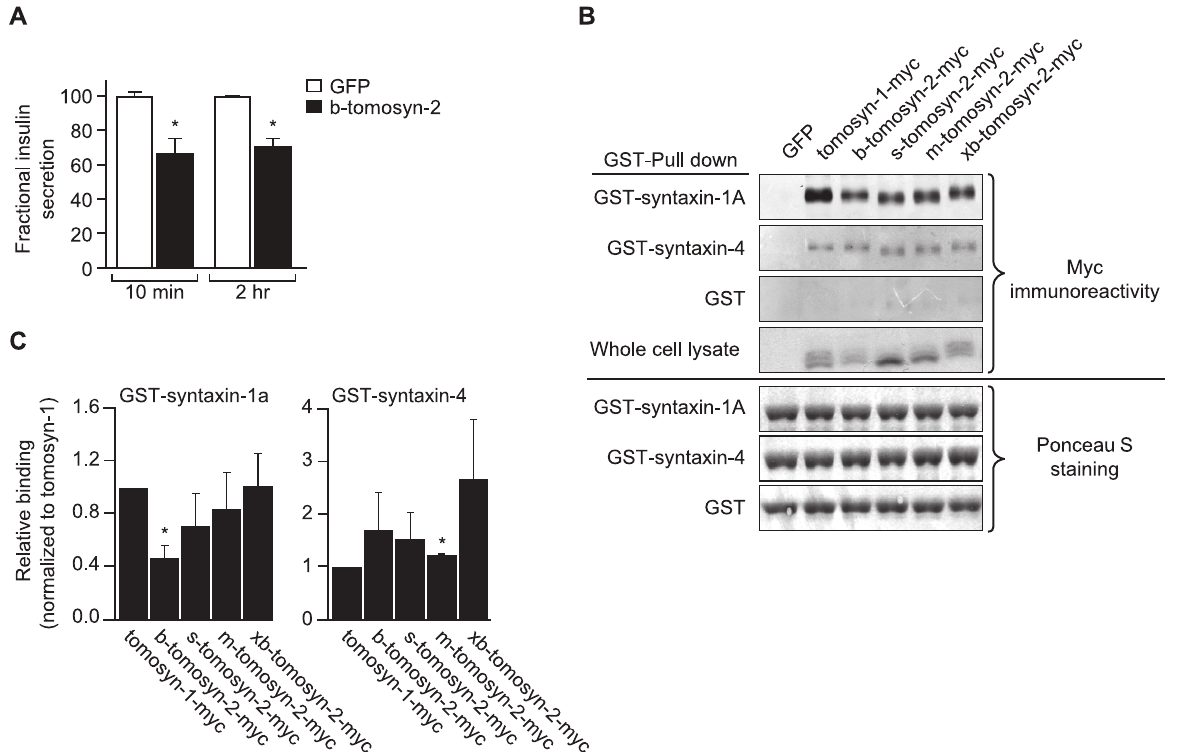
Figure 8. Overexpression of tomosyn-2 inhibits insulin secretion in INS1 (832/13) cells and binds syntaxin-1A and -4. A) INS1 (832/13) cells were plated in a 96-well plate (10 5 cells/well). After overnight incubation, the cells were cultured in RPMI supplemental media and transfected with a bicistronic mammalian expression plasmid containing either GFP or b-tomosyn-2 and GFP. After 36 h of incubation, the insulin secretion was measured. Fractional insulin secretion in response to 3 mM 8-bromo cAMP at 7 mM glucose from b-tomosyn-2 transfected cells was normalized to that of cells transfected with GFP. Values are means 6 S.E. of N $ 4. * p # 0.05 for the fractional insulin secretion from the cells overexpressing tomosyn-2 vs. GFP expressing cells. B) HEK 293T cells were transfected with mock, tomosyn-1-myc, or tomosyn-2-myc isoforms (b, s, m, and xb) mammalian expression plasmids. After 24 h, the cells were harvested and whole cell lysates (WCL) were prepared. GST-pull-down experiments were performed as described in Methods. Ponceau S staining shows input of the GST fusion proteins. The overexpression of the exogenous protein in HEK 293T cells was determined by subjecting the WCL to western blot using anti-myc antibody. C) The graphs show the binding of each tomosyn-2 isoform relative to the amount of bound tomosyn-1. Values are means 6 S.E. of